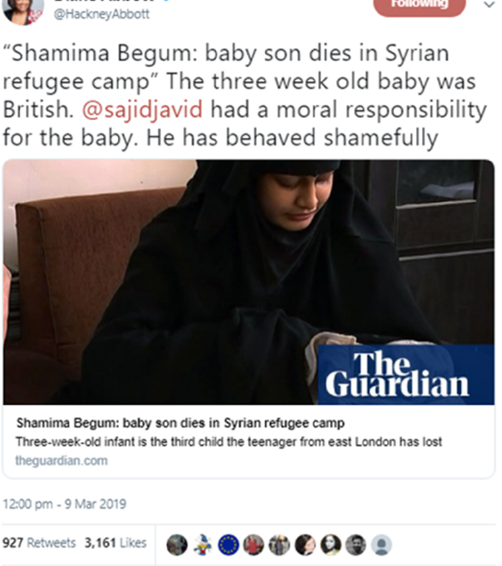
Figure 5. Tweet from Shadow Home Secretary Diane Abbott, 9 March 2019.